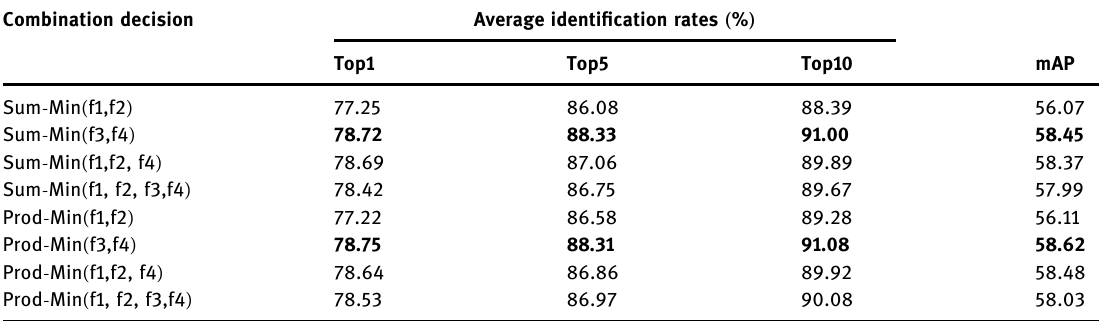
Combination decision